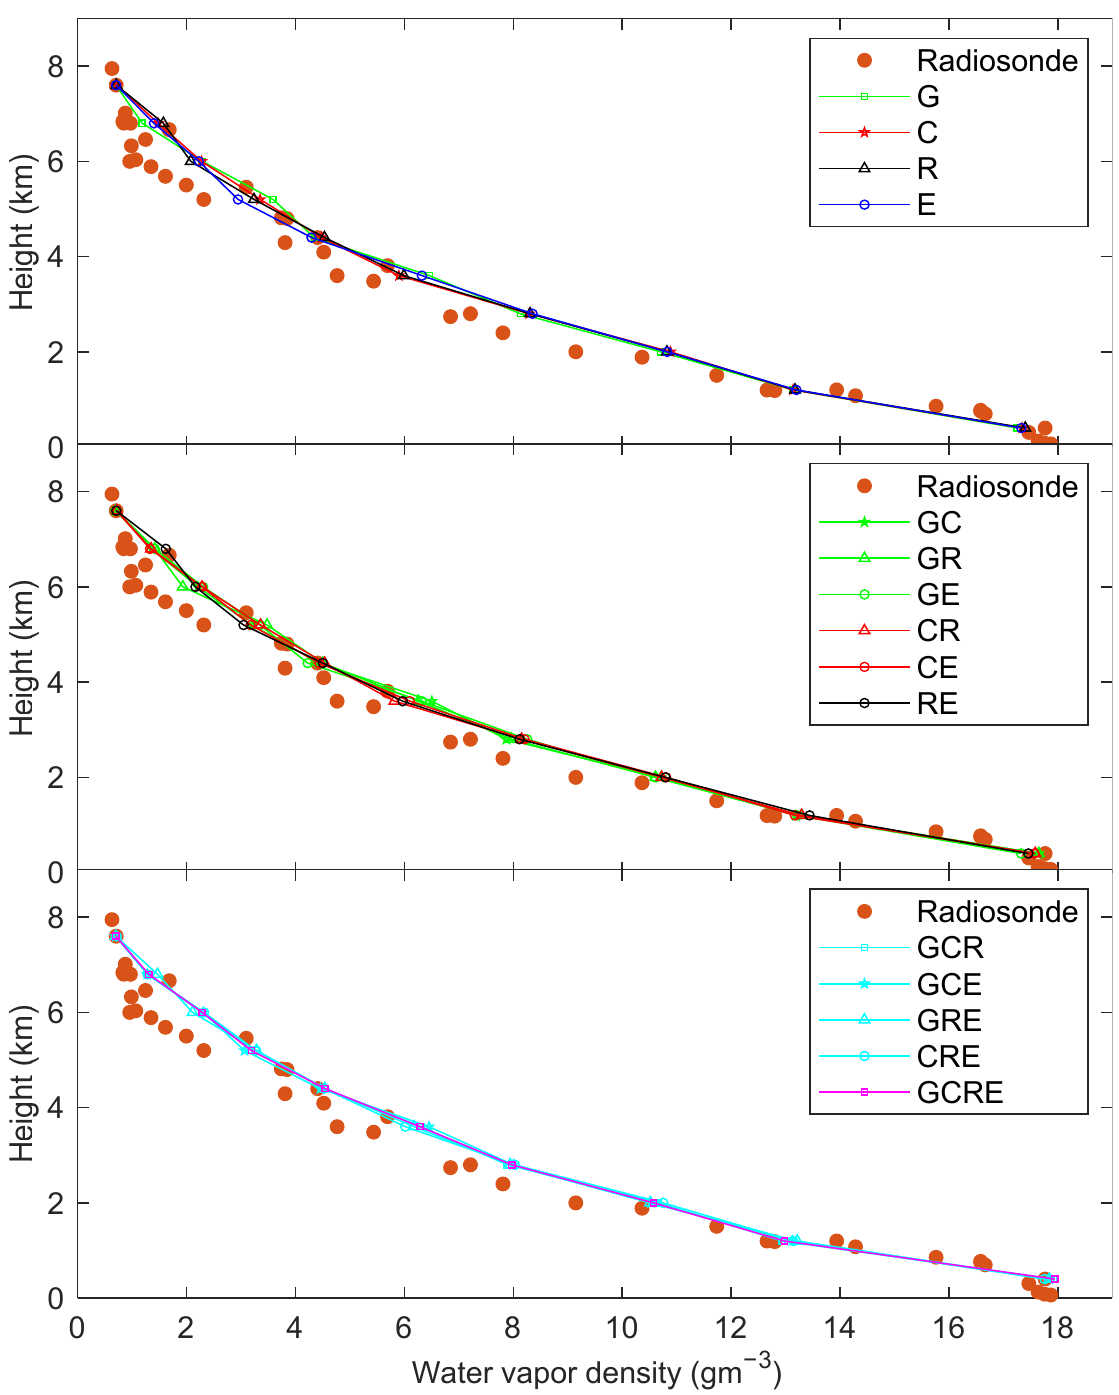
Figure 8. Water vapor density comparisons between radiosonde and 15 tomographic results.